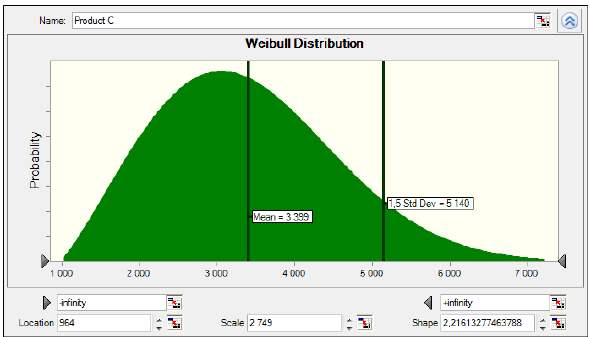
Figure 7: Distribution function for sale of product